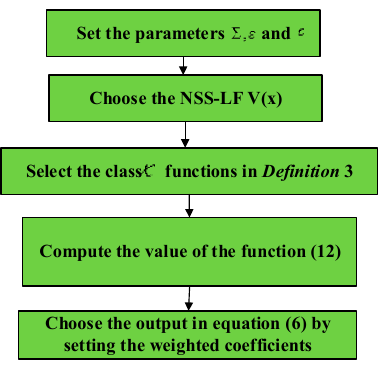
Figure 3. Flowchart of the proposed noise-to-state stability (NSS) based approach. LF: Lyapunov function.